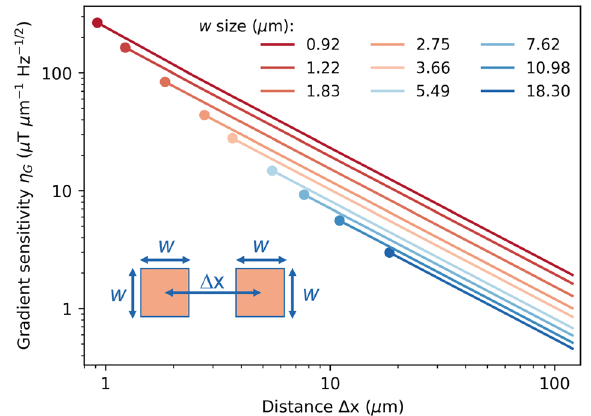
Fig. 4 | Magnetic fi eld gradient sensitivity. The inset shows two virtual point sensorswithgivensizeof w × w andgapdistanceof 4 x ð4 x ≥ w Þ .Thedotsattheleft end of each curve represent the starting position where 4 x = w , indicating the spatial resolution limit of the fi eld gradient. The fi gure is in log – log scale